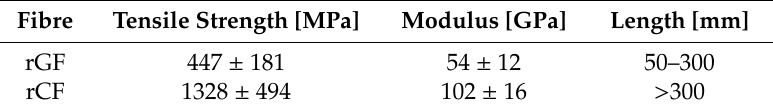
Table 1. Properties of the recycled glass (rGF) and carbon (rCF) fibres used in the